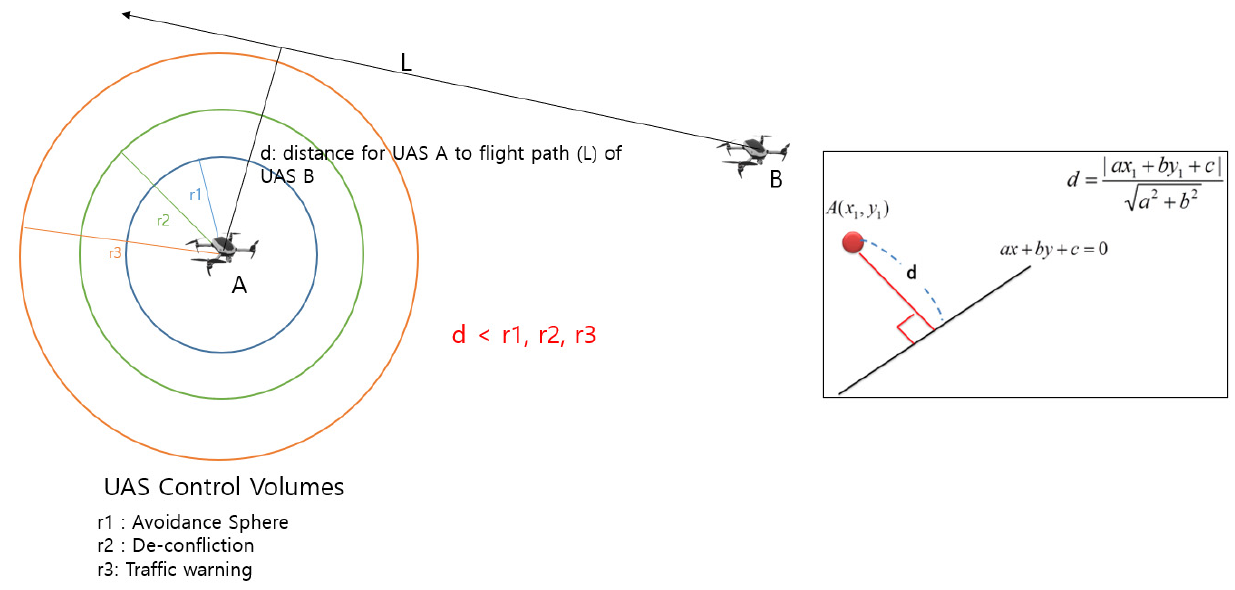
Figure 11. Conflict conditions between two UASs (UAS A and B).